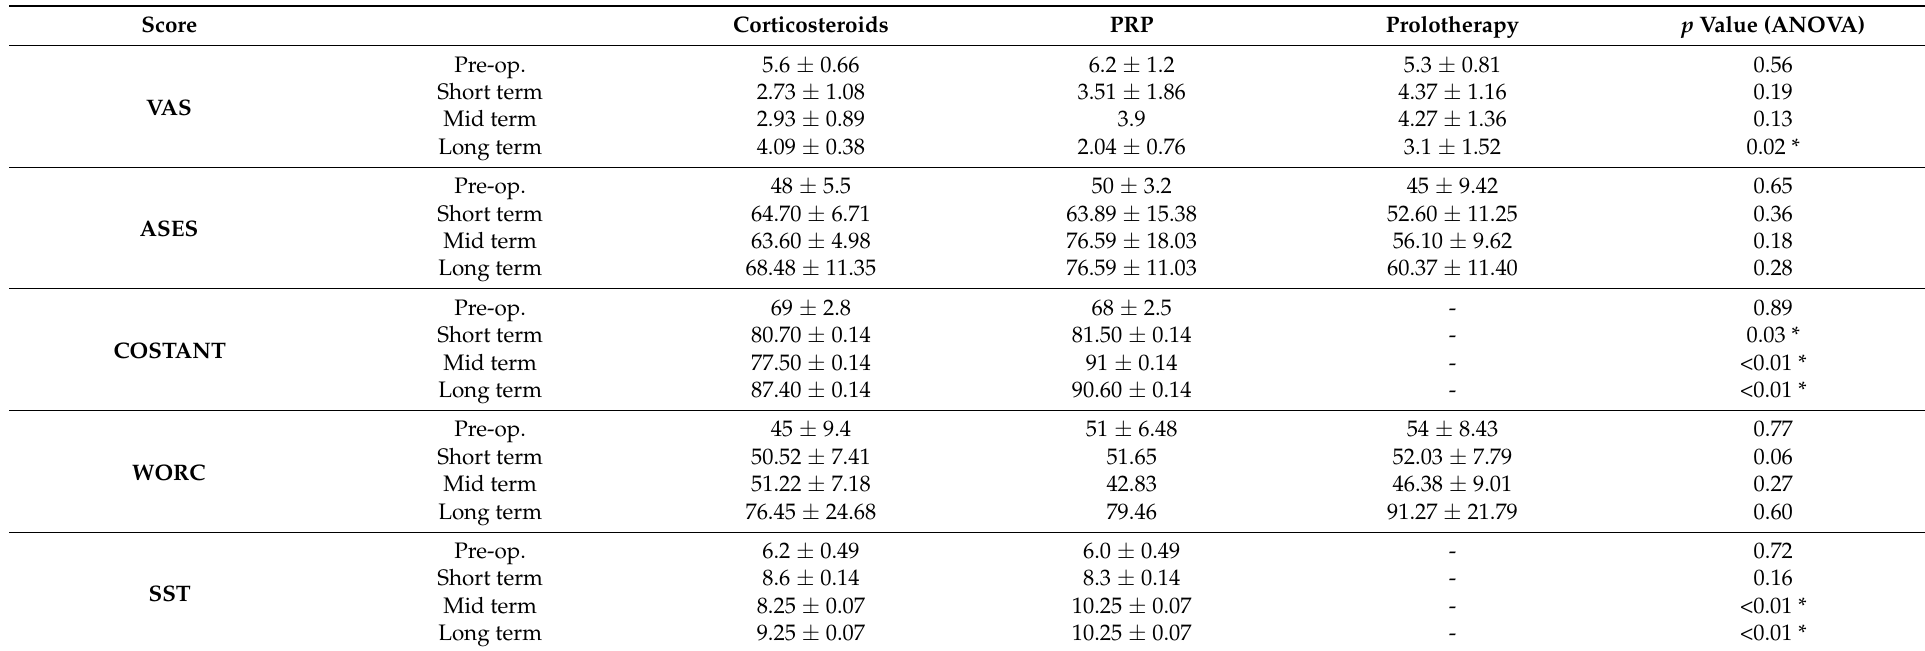
Table 4. Clinical Outcomes. Bold characters denote significant values. * p <